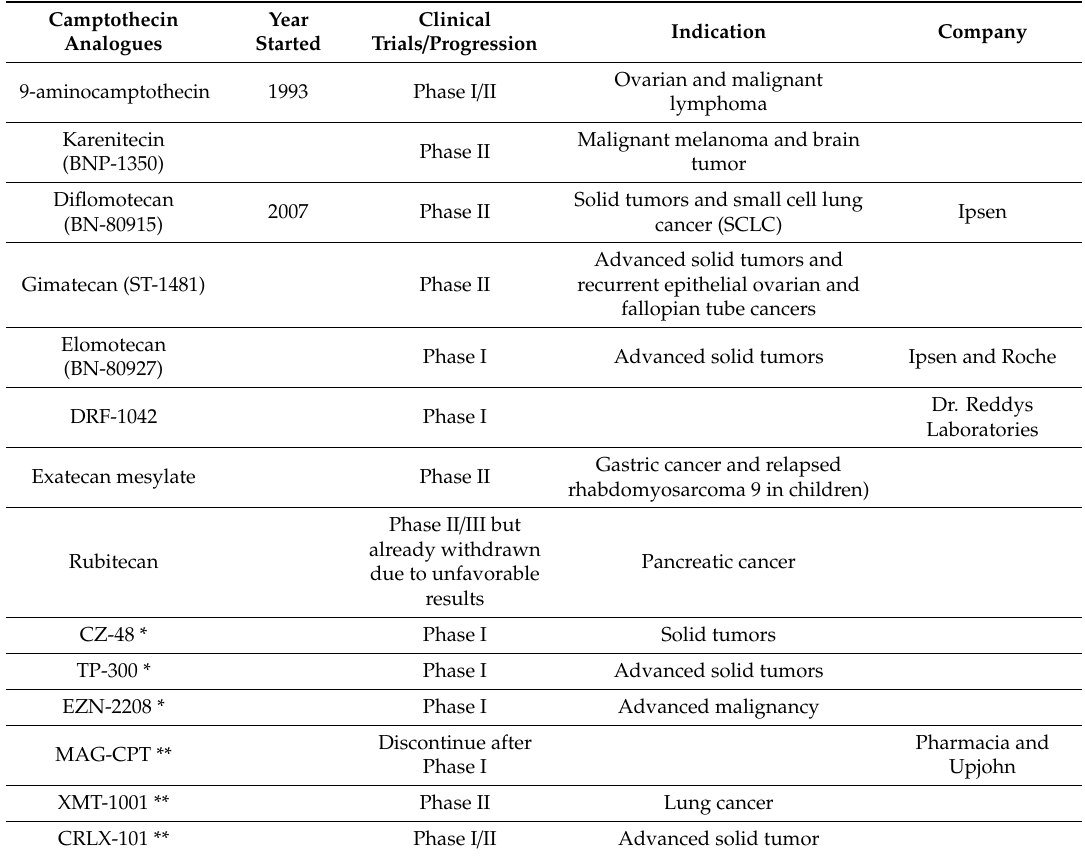
Table 6. Clinical trials of camptothecin analogues. Adapted from [9].